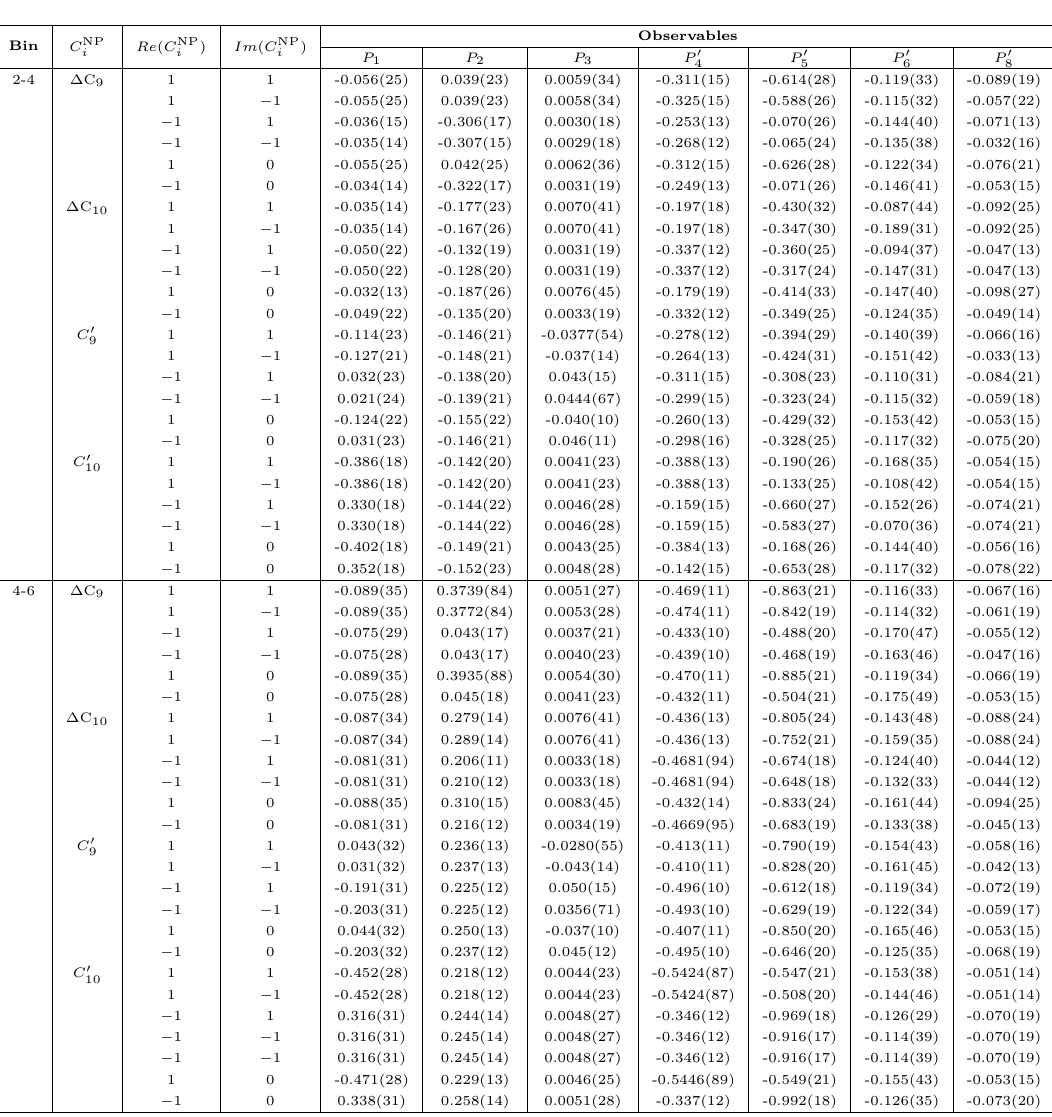
Table 25 . The dependence of the optimized observables corresponding to B ± → ρ ± ll on the real and imaginary parts of the NP WC’s ∆ C few benchmark values of the real and imaginary parts of the corresponding